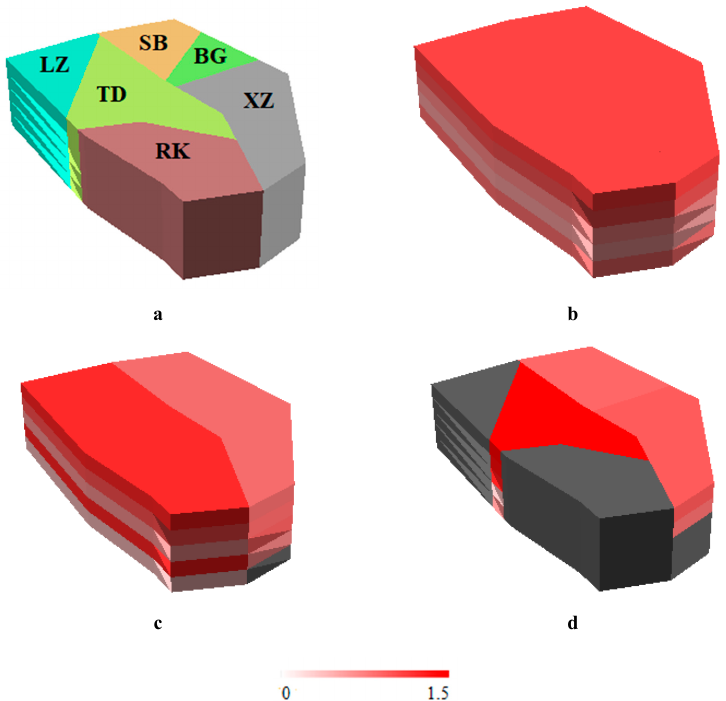
Figure 8. Study area and results from the tri-class seismic source model in different depth layers ( Δ D ) ( a ) represents the zones of different tectonic features; ( b ) represents the study area ( Δ D ); ( c ) represents the east and west seismic tectonic zones ( Δ D ), and ( d ) represents the different zones of tectonic features ( Δ D ). The shades of red indicate the value of Δ D, and gray indicates areas that do not have data).